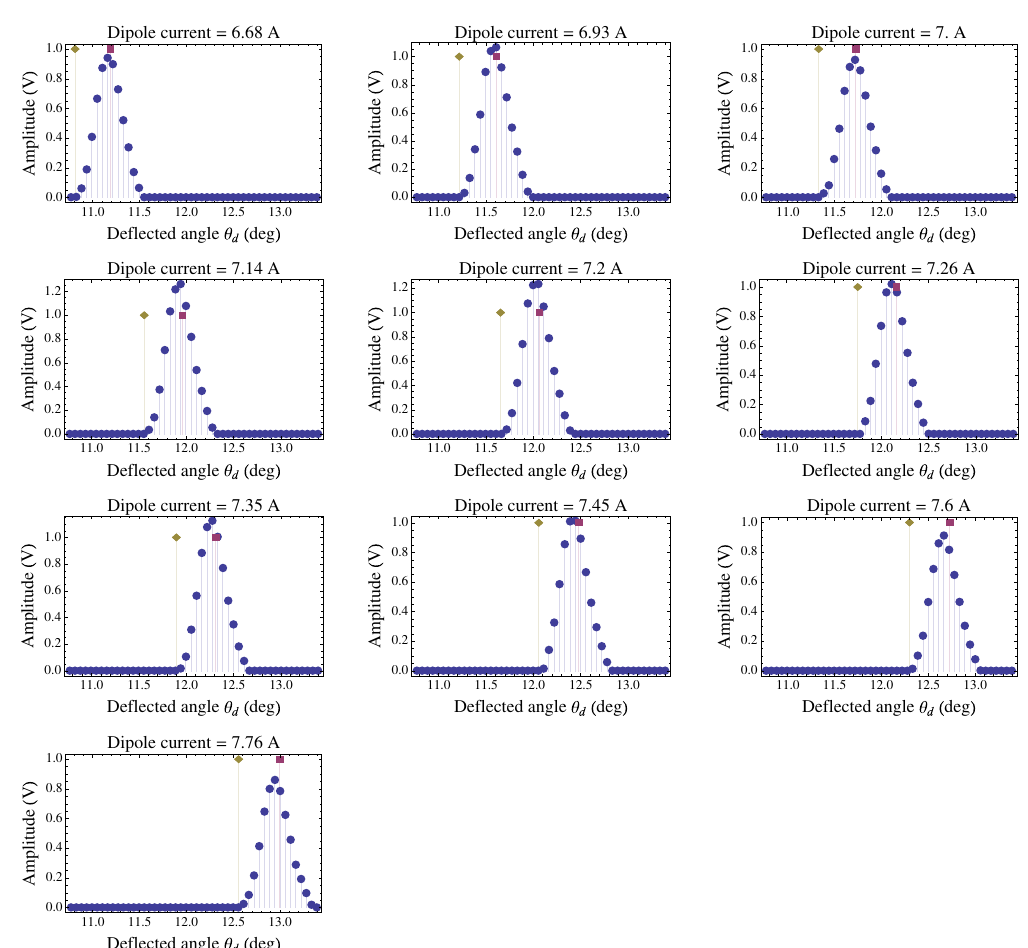
FIG. 13. The spectrometer data for the case when the RFQ is at 156 kW net power. As expected, the entire angular distribution moves when the dipole current is changed. The gray diamond indicates the expected deflection angle for 750 keV beam and the red square indicates the expected deflection angle for 700 keV beam. The peak of the distribution is clearly above 700 keVand the mean energy is found to be 703